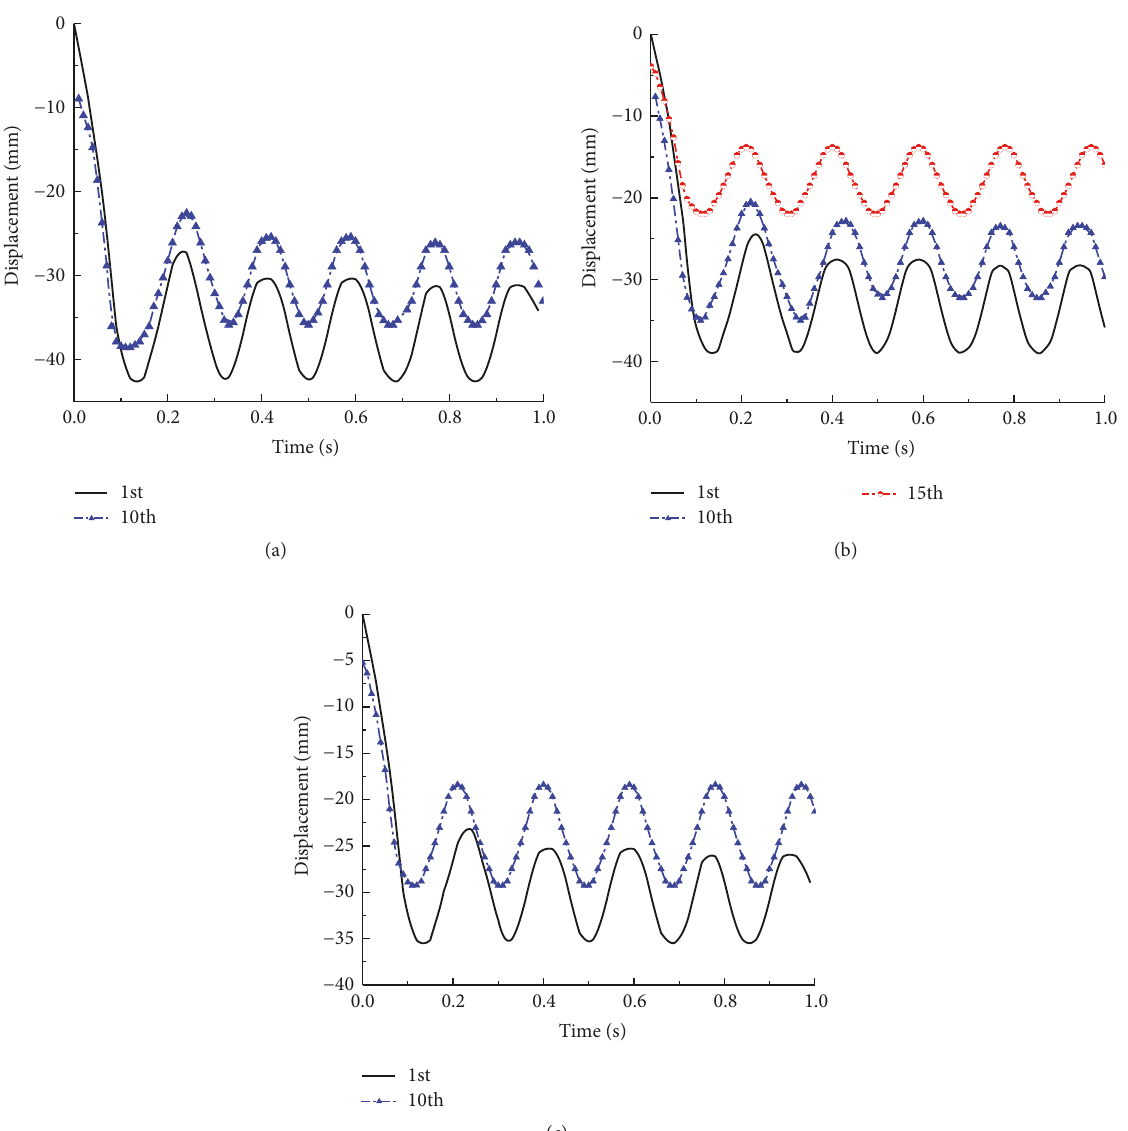
Figure 9: Removal of the corner columns in building: (a) 10-story model; (b) 15-story model; (c) 10-story model of the 8-degree seismic design; (a)–(c) vertical displacement of the joint at the top of the removed column on the 𝑥 th-story.